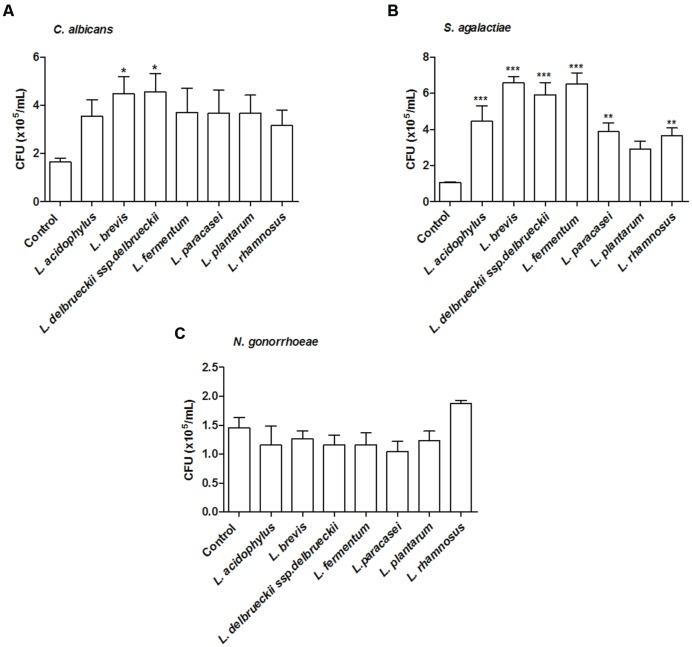
Inhibition of mucin adhesion by exclusion. Effect of different lactobacilli on (A)
C. albicans, (B)
S. agalactiae, and (C)
N. gonorrhoeae binding to mucin. The values are expressed in CFU/ml and represent the means of the values obtained. For all experiments, the purity of the colonies was checked both macroscopically (by the growth aspects) and microscopically (by the Gram stain). The assay was performed in triplicate. ∗p < 0.05; ∗∗p < 0.01; ∗∗∗p < 0.001.